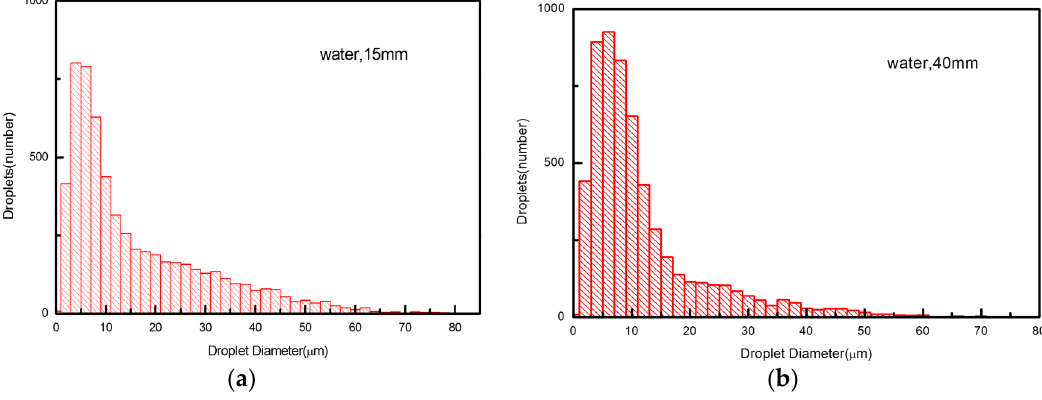
Figure 7. Water droplet size distribution at different cross ‐ sections at 15 mm ( a ), and 40 mm ( b ).